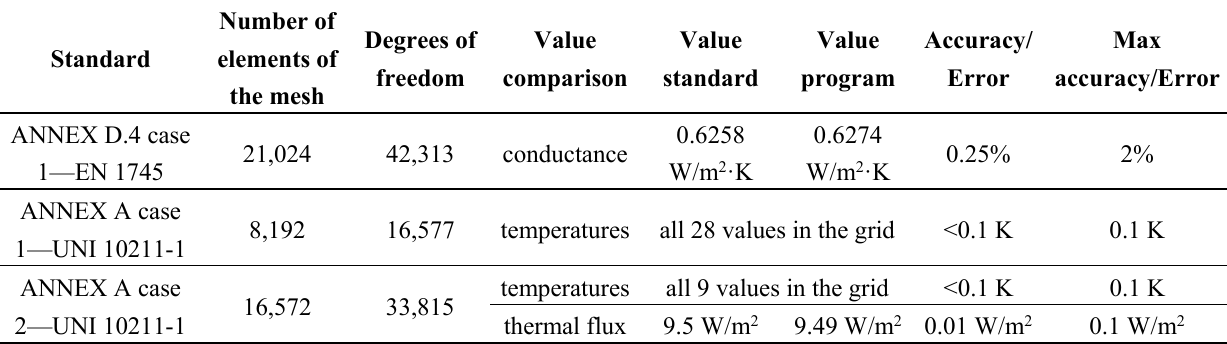
Table 1. Results of the numerical method and software validation, reprinted with permission from [19], copyright Elsevier